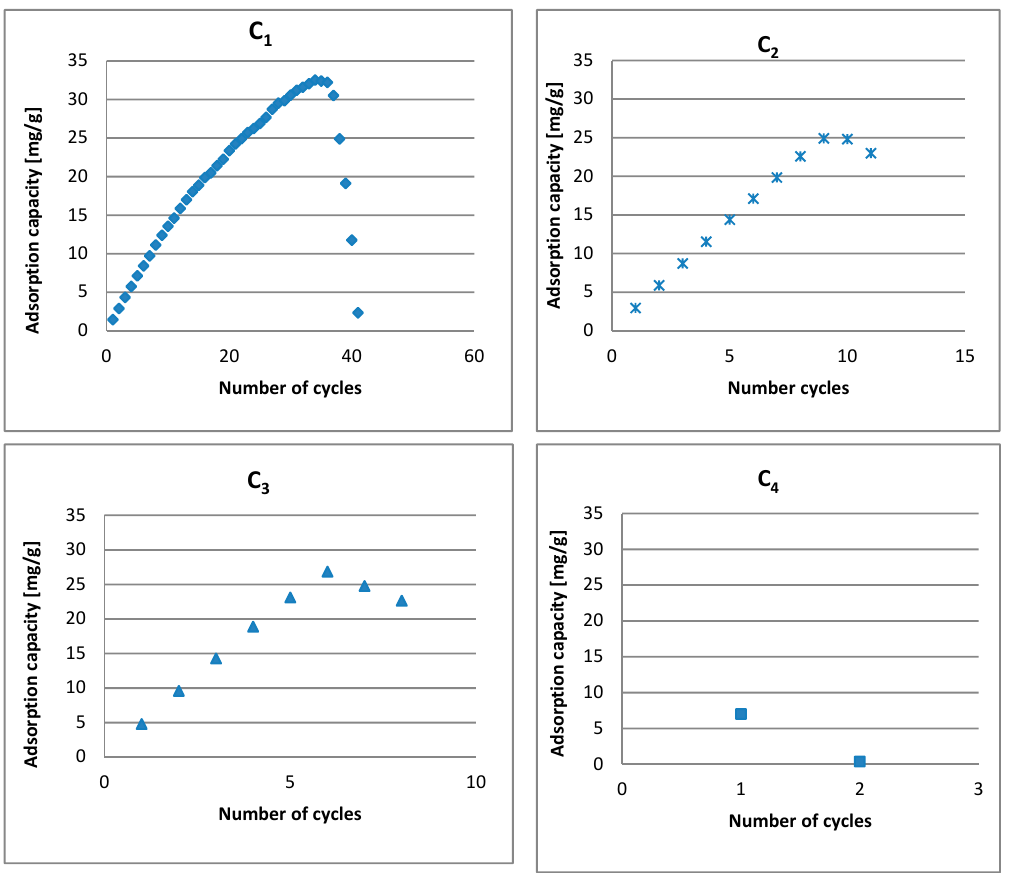
Figure 5. Adsorption capacity as a function of number of cycles. The obtained exploitation values from the ratio (R) between retained substance until color change (mg Ret ) and the amount of MWCNTs (g MWCNTs ) used in the column were calculated (Table 4). The column C1 ensured a better use of MWCNTs. The efficiency of removal of columns (RE) for each cycle is plotted in Figure 6. It was obtained using Equation (5):